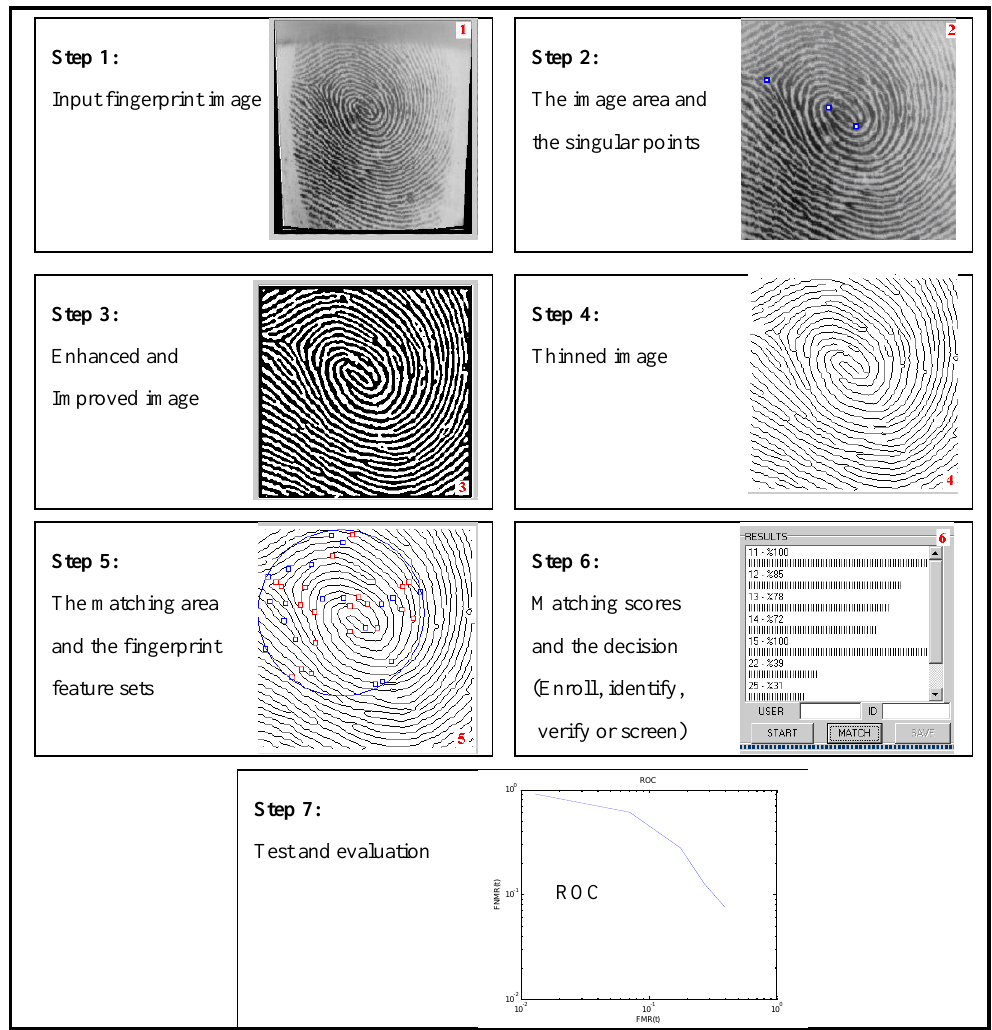
Figure 3. Main operational steps of minutiae-based AFIVSs